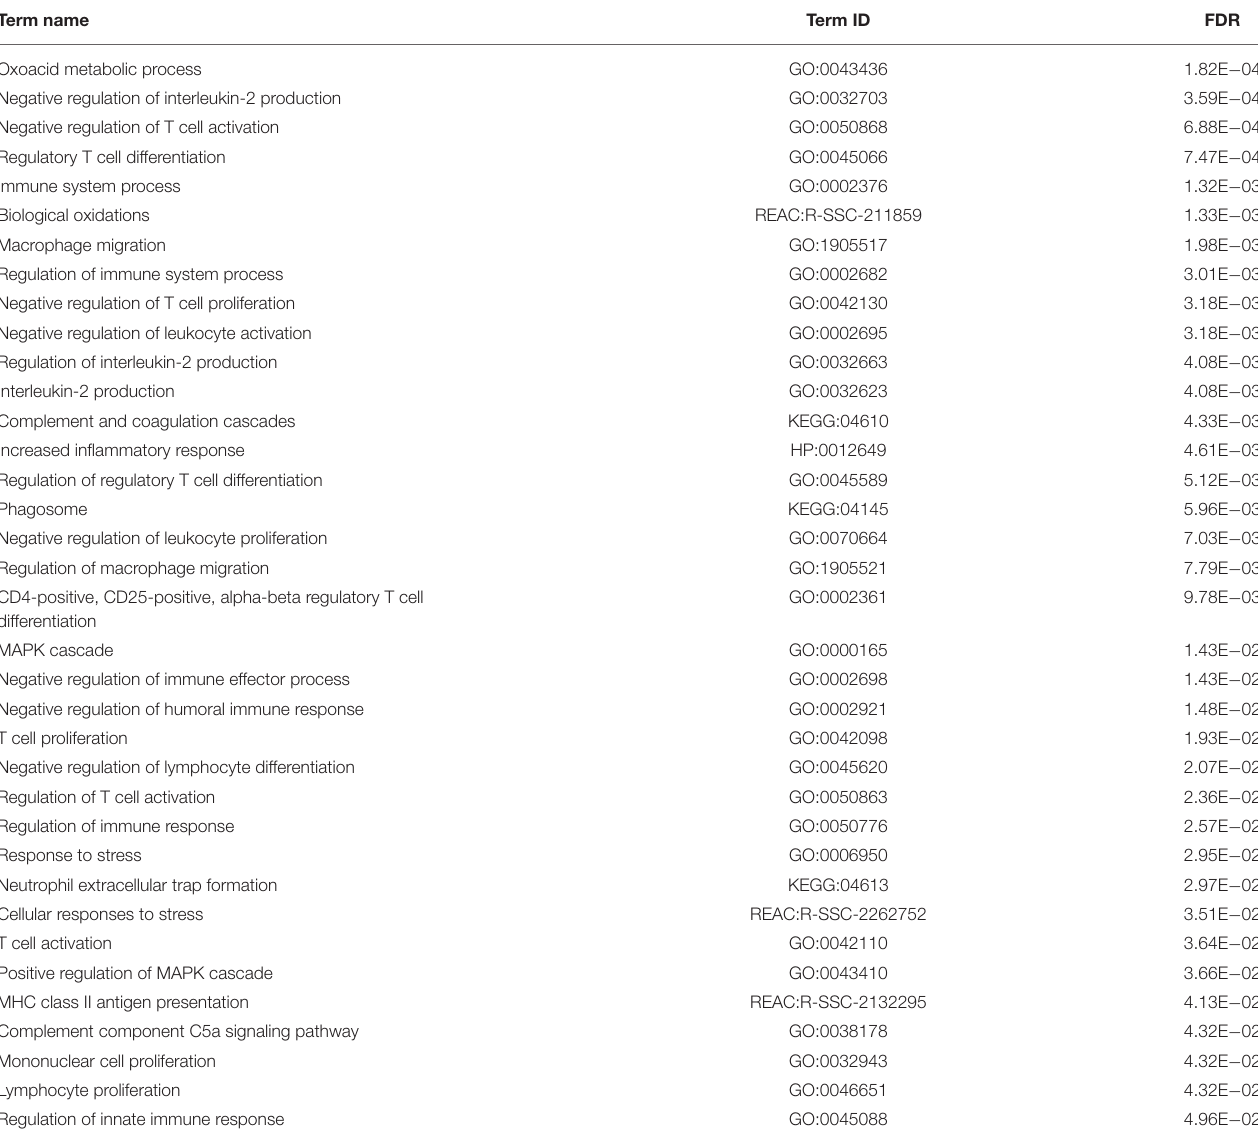
TABLE 2 | MLV-129p-IFNmix GO terms related to immunity, stress, and homeostasis in porcine